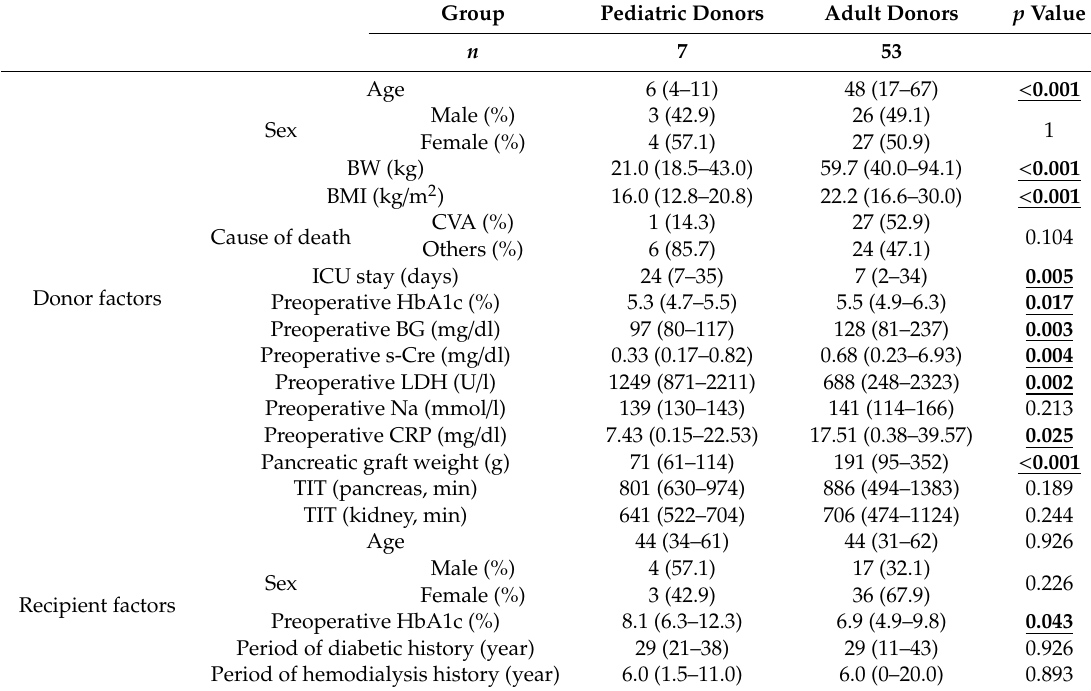
Table 3. The donor and recipient backgrounds of the pediatric donor (PD) group and the adult donor (AD)